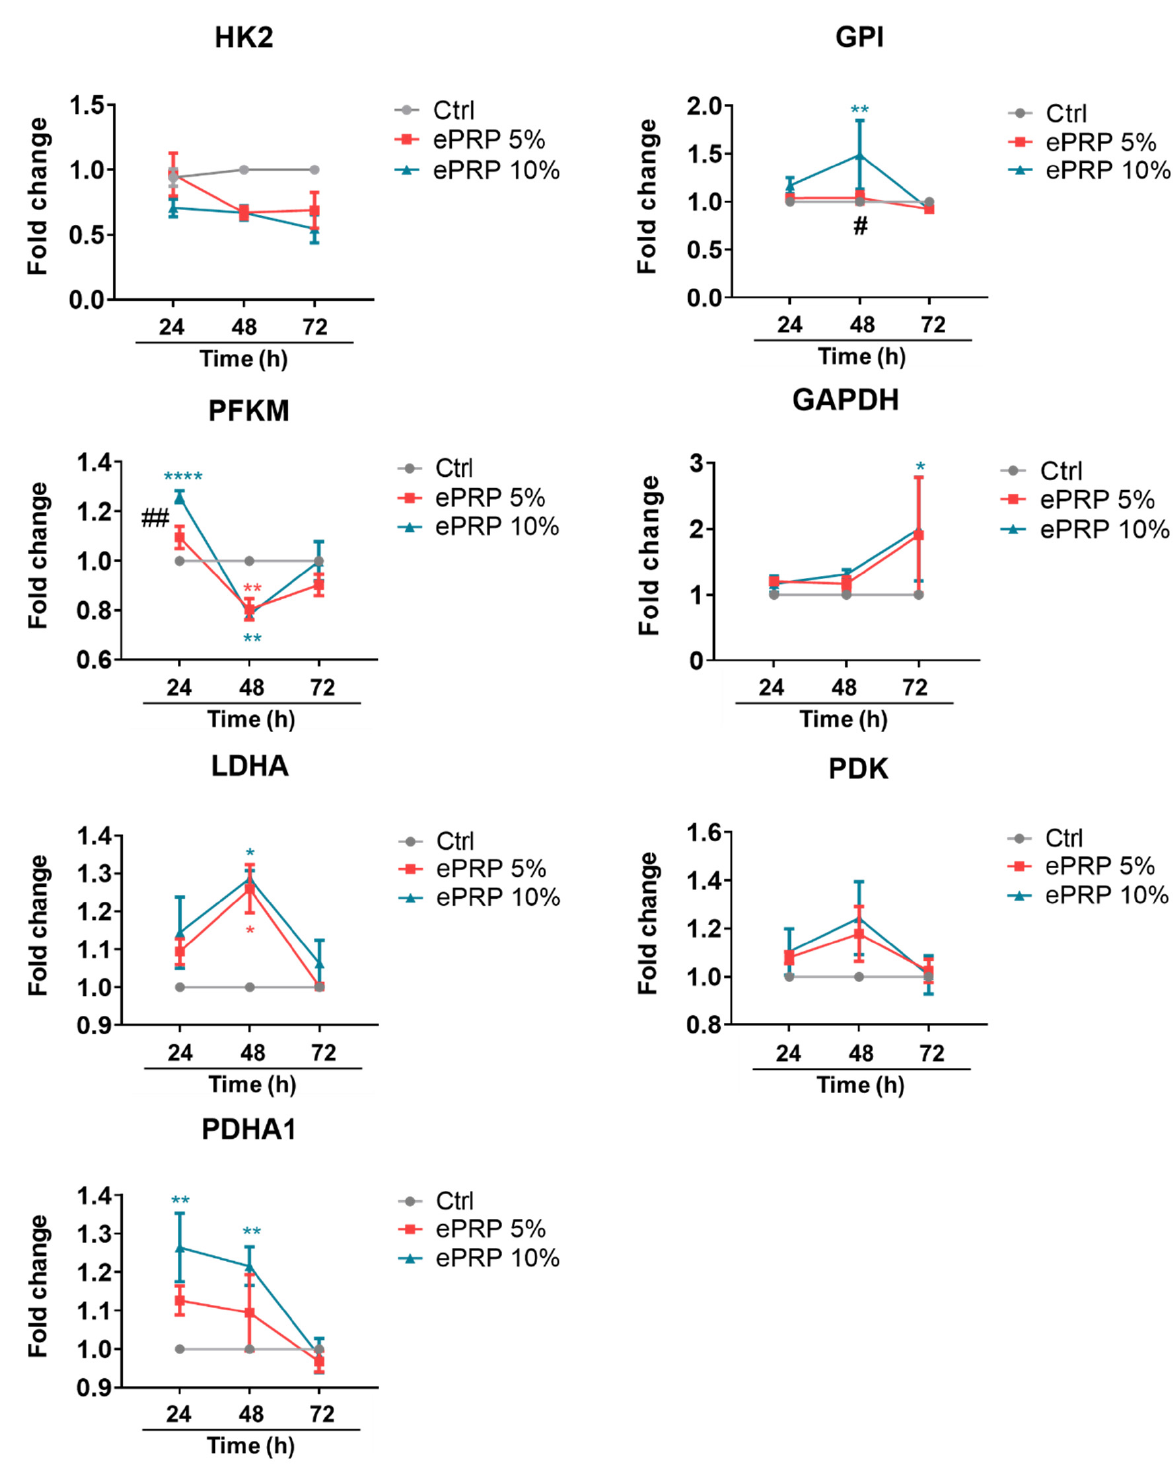
Figure 3. The gene expression of glycolytic enzymes in fibroblasts is stimulated by ePRP. Quantitative real-time PCR was utilized to evaluate the mRNA expression levels of multiple glycolytic enzymes in fibroblasts treated with ePRP for 24, 48, and 72 h. The 2 −ΔΔ Ct method was used to calculate relative gene expression of fold changes, employing EEF1A1 as the internal control. Two-way ANOVA with Tukey’s multiple comparisons test was used to determine statistical significance. * illustrates the statistical difference between each group (* p < 0.05, ** p < 0.01, **** p < 0.0001); # shows the statistical difference between 24 and 48 h ( # p < 0.05, ## p < 0.01). The data are shown as mean ± SEM (N =